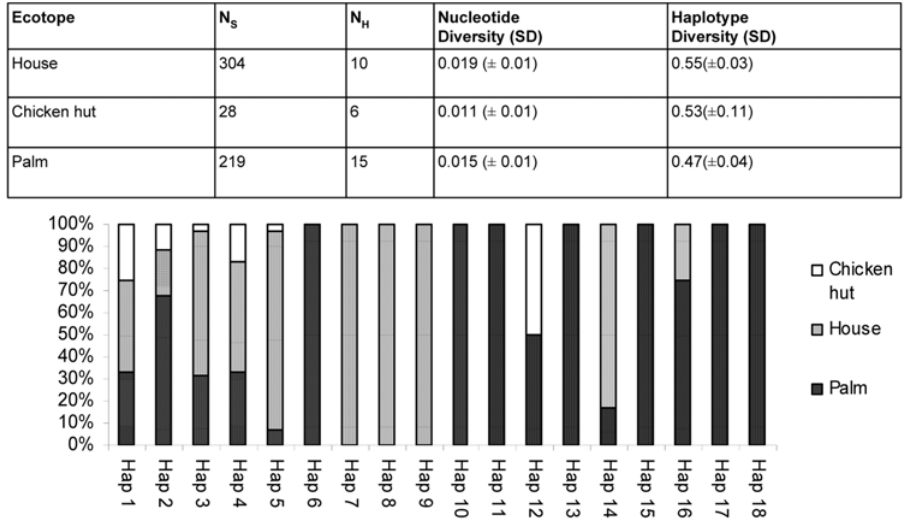
Figure 4. Genetic diversity and haplotype distribution in the sampled ecotopes.